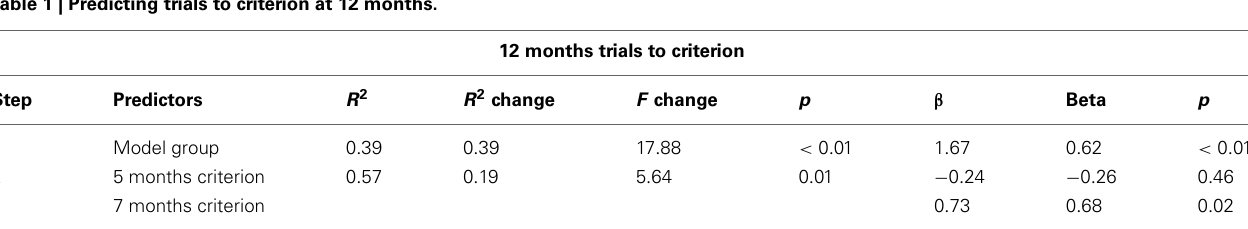
12 months trials to